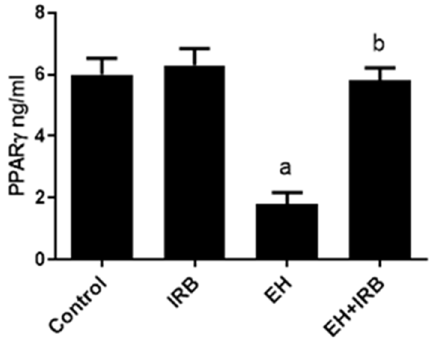
Figure 6. Effect of irbesartan (IRB) on peroxisome proliferator-activated receptor gamma (PPAR γ ) in estradiol benzoate-induced endometrial hyperplasia (EH) and atypia in rats. Values are mean ± SEM ( n = 6–7). a,b Significantly different ( p < 0.05) from control and EH groups, respectively.